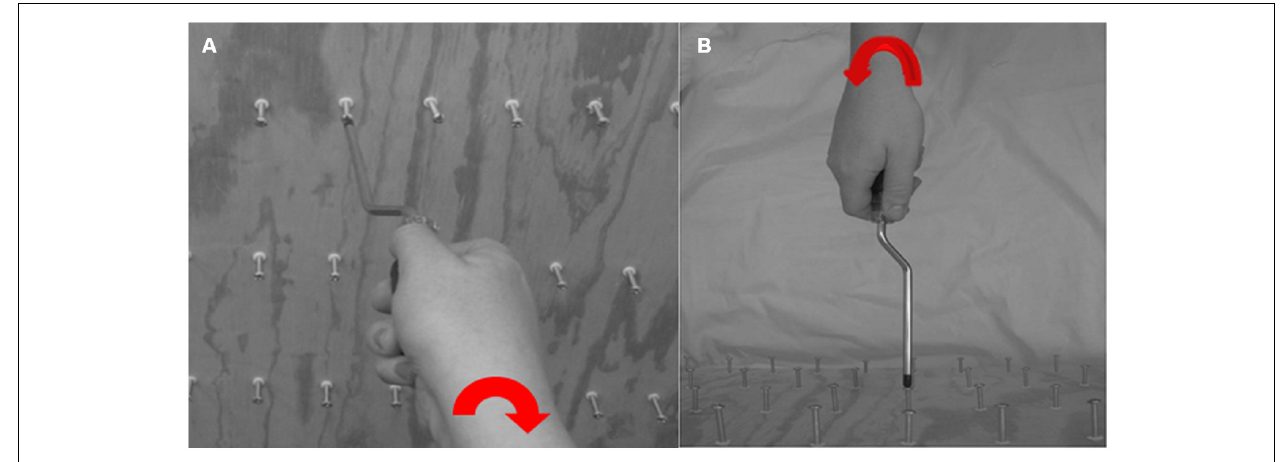
FIGURE 3 |The wooden board with screws that were mounted for subject training; (A) an exemplar image for right-handed egocentric rotating screwdriver driving a screw “in” and (B) an exemplar image for a left-handed allocentric rotating screwdriver pulling a screw